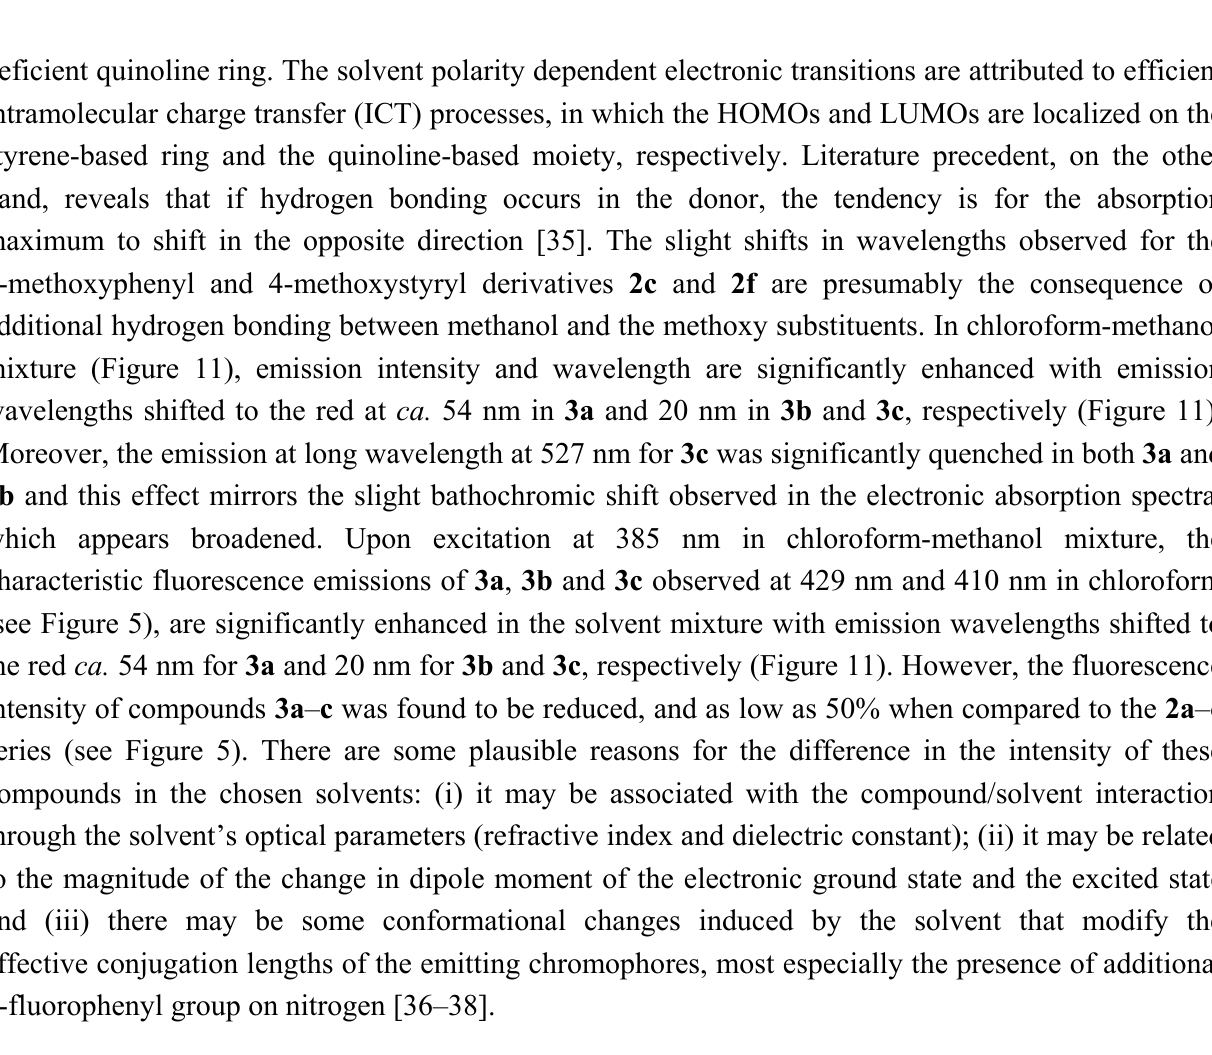
Figure 10. The fluorescence emission spectra of 2a – f ( λ (1:1, v/v) (conc. 2.0 × 10 − 7 mol/L) at